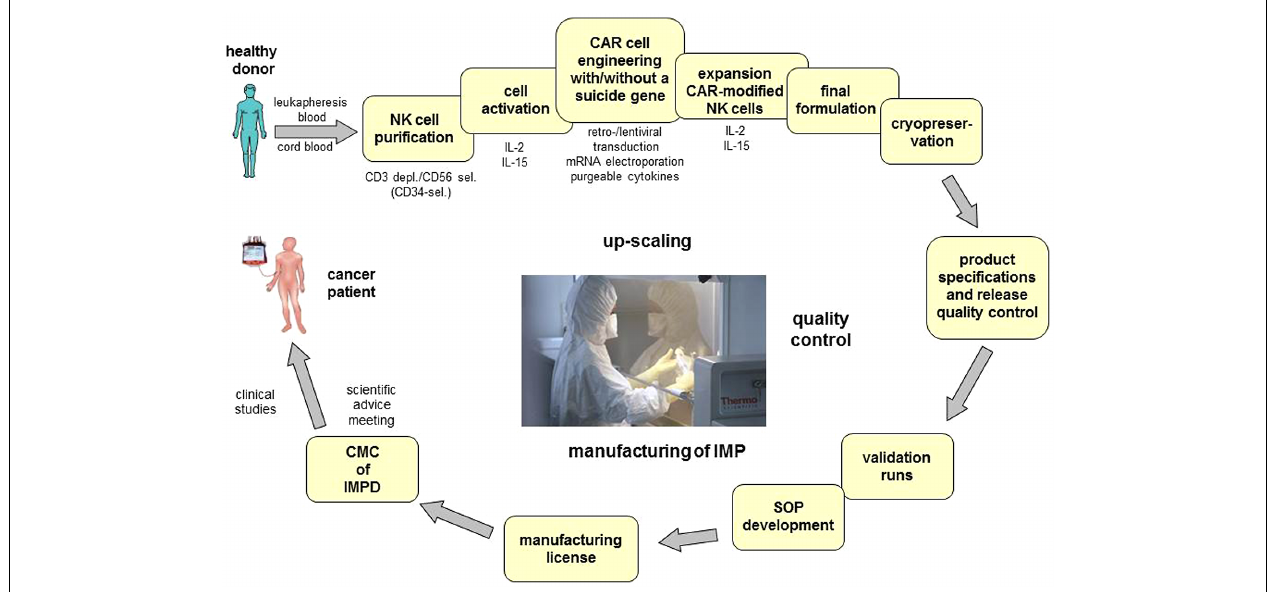
clinical phase I/II trial the corresponding SOPs will be generated, validation runs will be performed and the application for manufacturing licenses has to be submitted. Due to the maturation status of the NK cells suicide genes might be necessary to improve safety in the use of CAR-engineered NK cells. CAR, chimeric antigen receptor; ATMP, advanced therapy medicinal products; depl., depletion; sel., selection; SOP, standard operation protocol; IMP, investigational medicinal product; IMPD, investigational medicinal product dossier; CMC, chemical manufacturing and